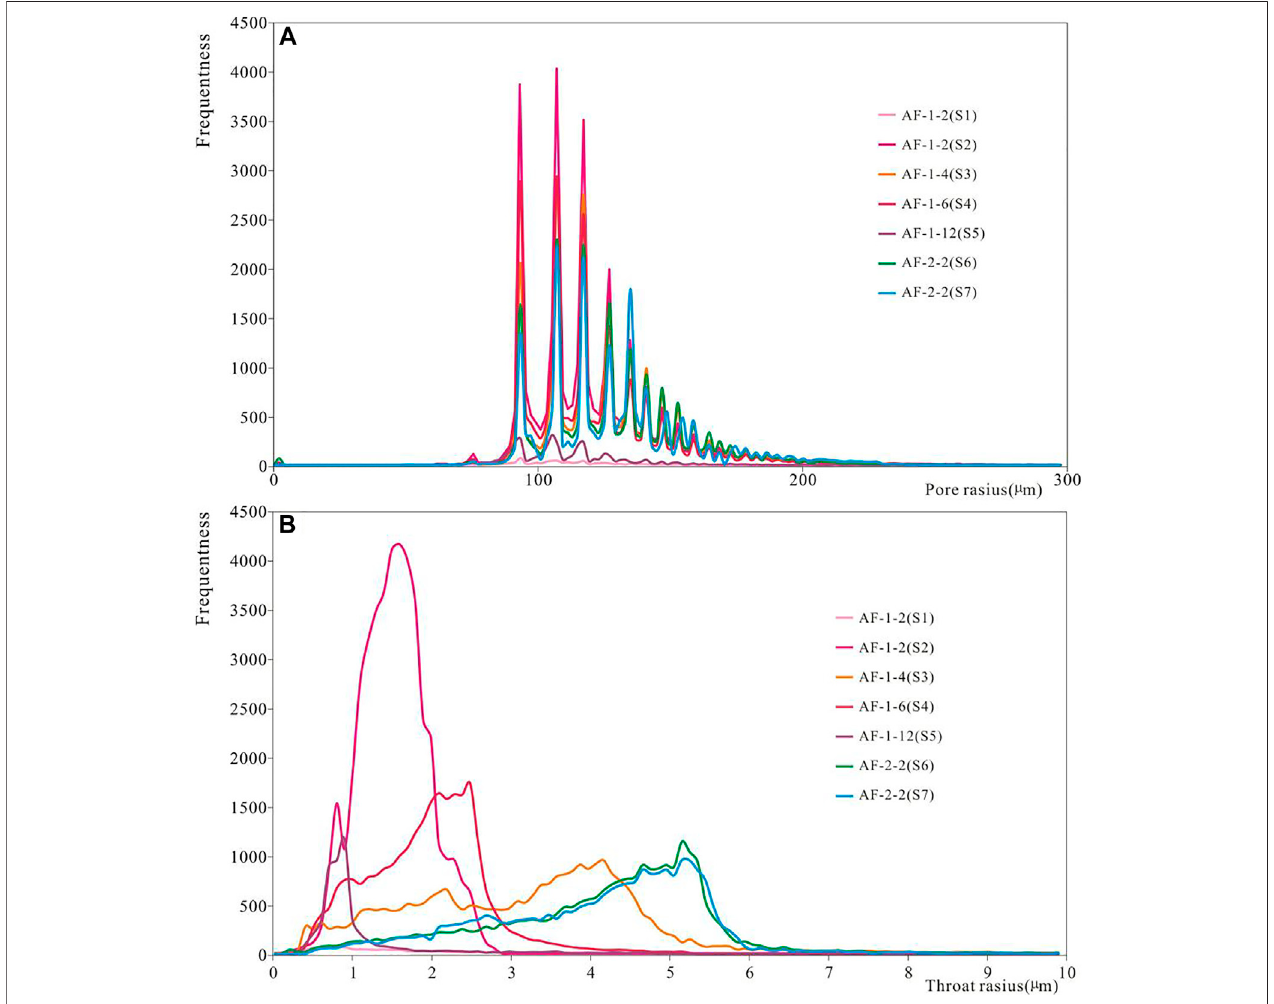
FIGURE4| Distributioncurvesof (A) poreradiusand (B) throatradiusfromsevensamplesoftheHuangliusandstonesin fi vewellsfromtheAF-1areaandtheAF-2 area, respectively.